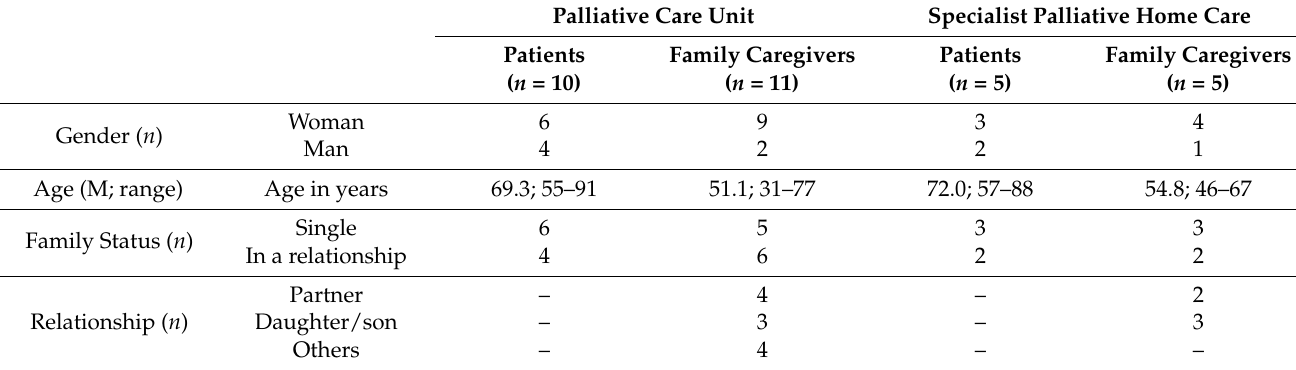
Table 2. Characteristics of patients and family